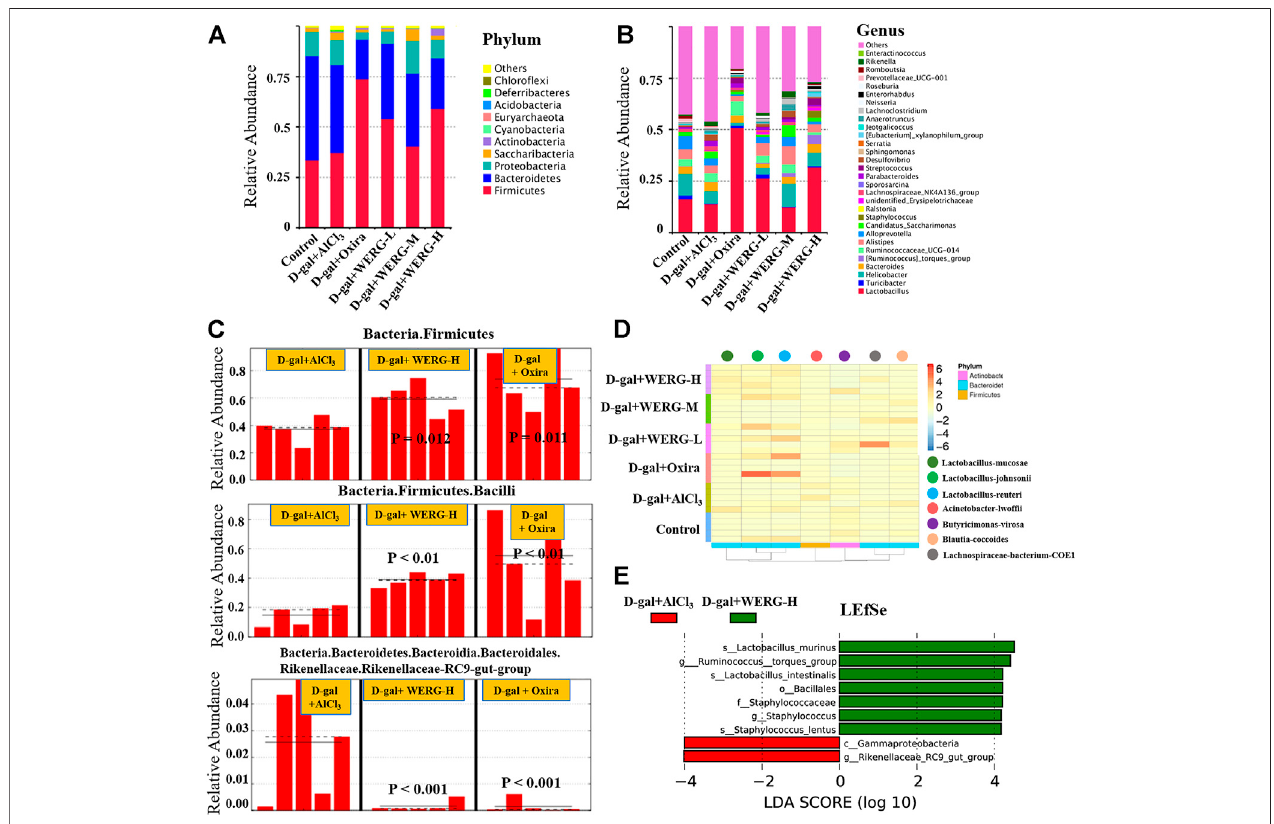
FIGURE 5 | WERG-H alleviated gut microbiota dysbiosis in AlCl 3 /D-gal-induced AD mice. The relative abundance at the phyla level (A) ; the relative abundance at the genus level (B) ; biomarker raw images in the sample (C) ; heatmap analysis of microbial composition (D) ; LEfSe analysis (E) . n = 5 mice per group.